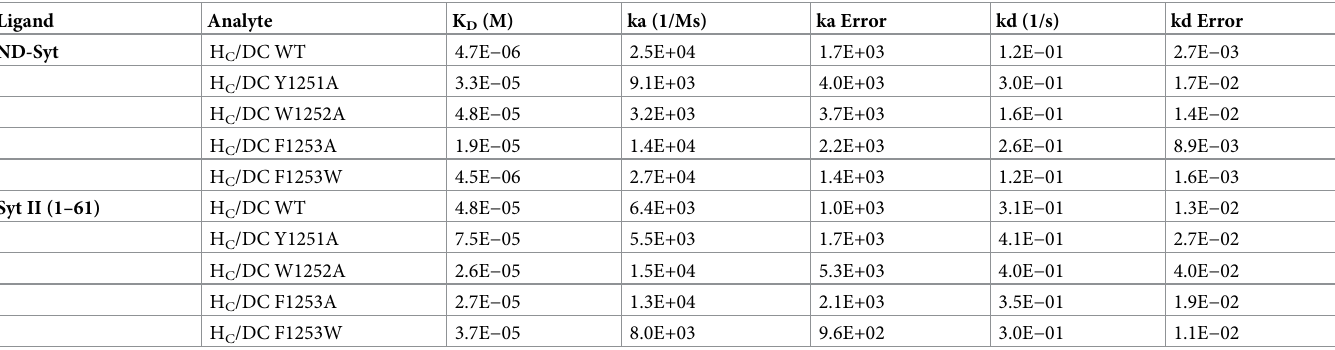
Table 1. Kinectics and affinity analysis of H C /DC and the indicated mutants to ND-Syt or free Syt II (1–61). Ligand